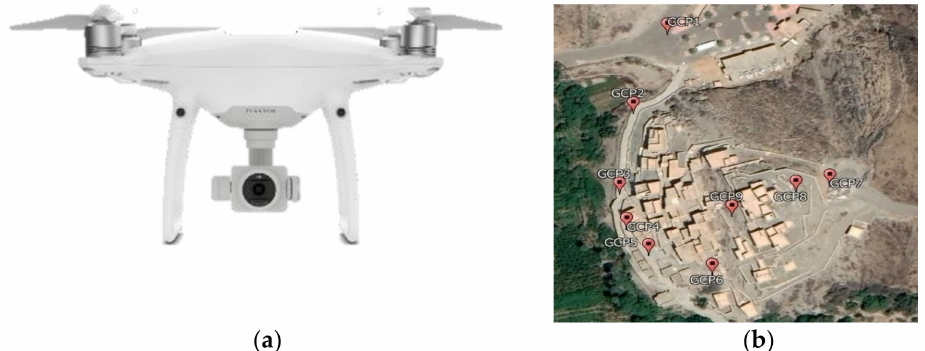
Figure 8. ( a ) DJI phantom drone; ( b ) ground control points